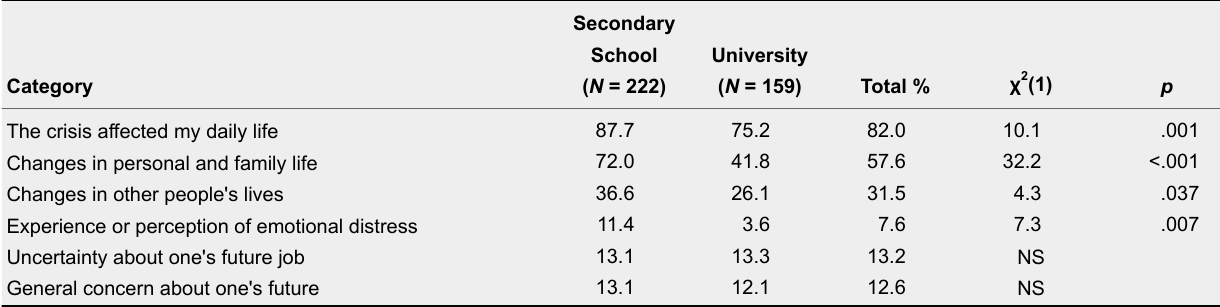
Consequences of the crisis perceived by Italian students (percentages)